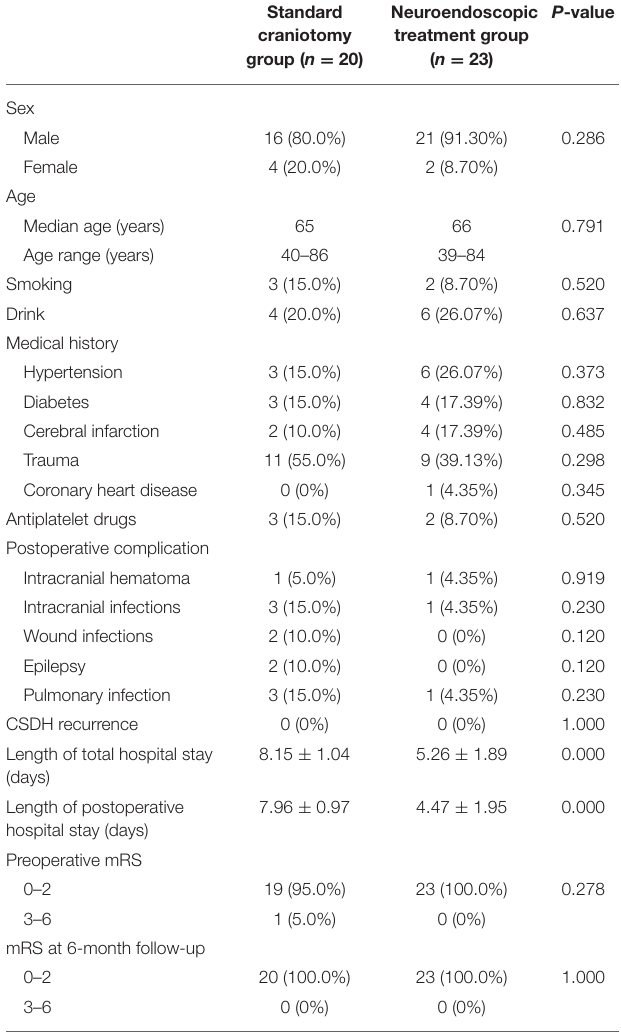
TABLE 1 | Characteristics of the septated chronic subdural hematomas among the patients.